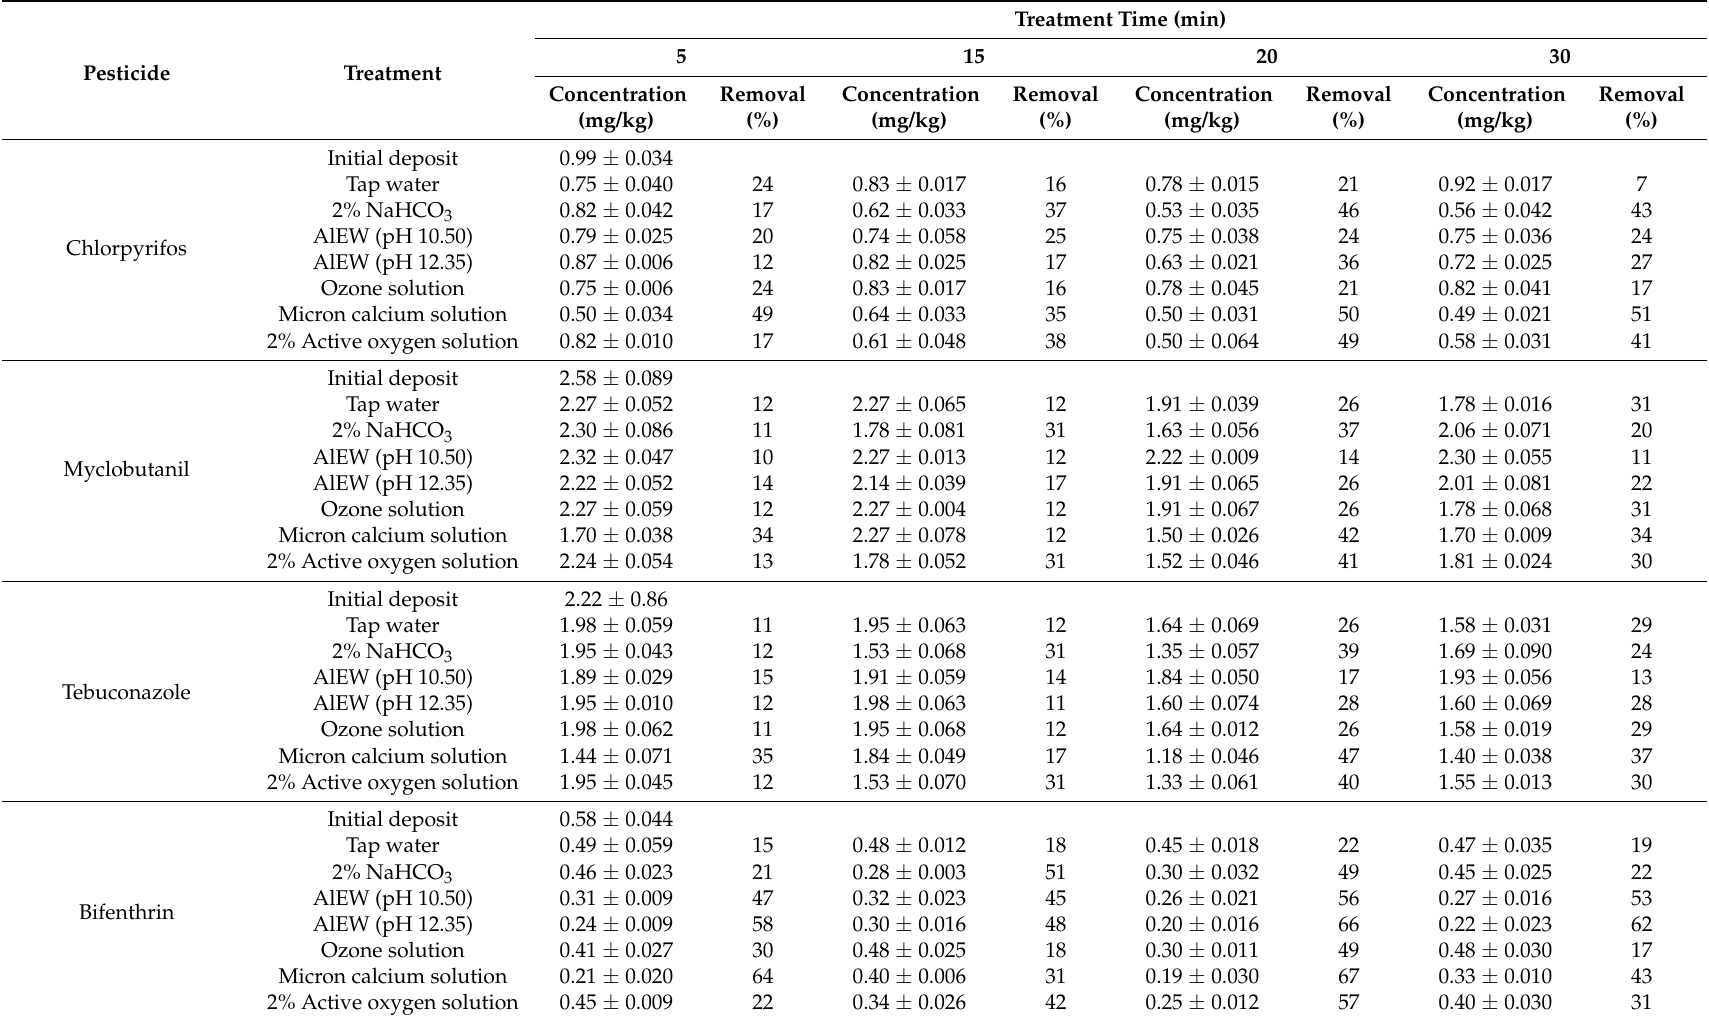
Table 7. Effect of washing treatments for pesticide removal in cucumber ( n =